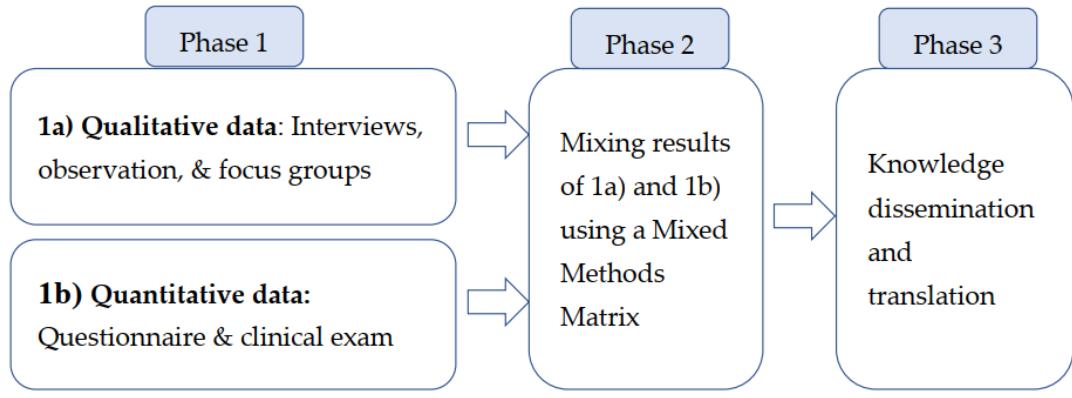
Figure 1. Diagram of mixed method study design.